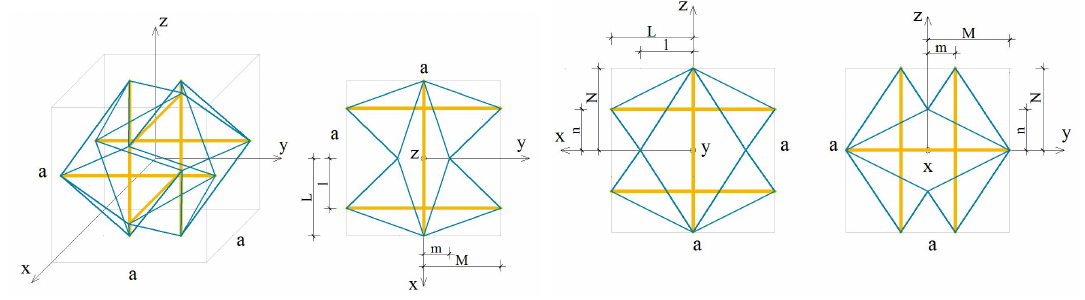
Figure 10. Geometry of the expanded octahedron module, with adopted parameters: l / L = 0.65, m / M = 0.30, n / N =